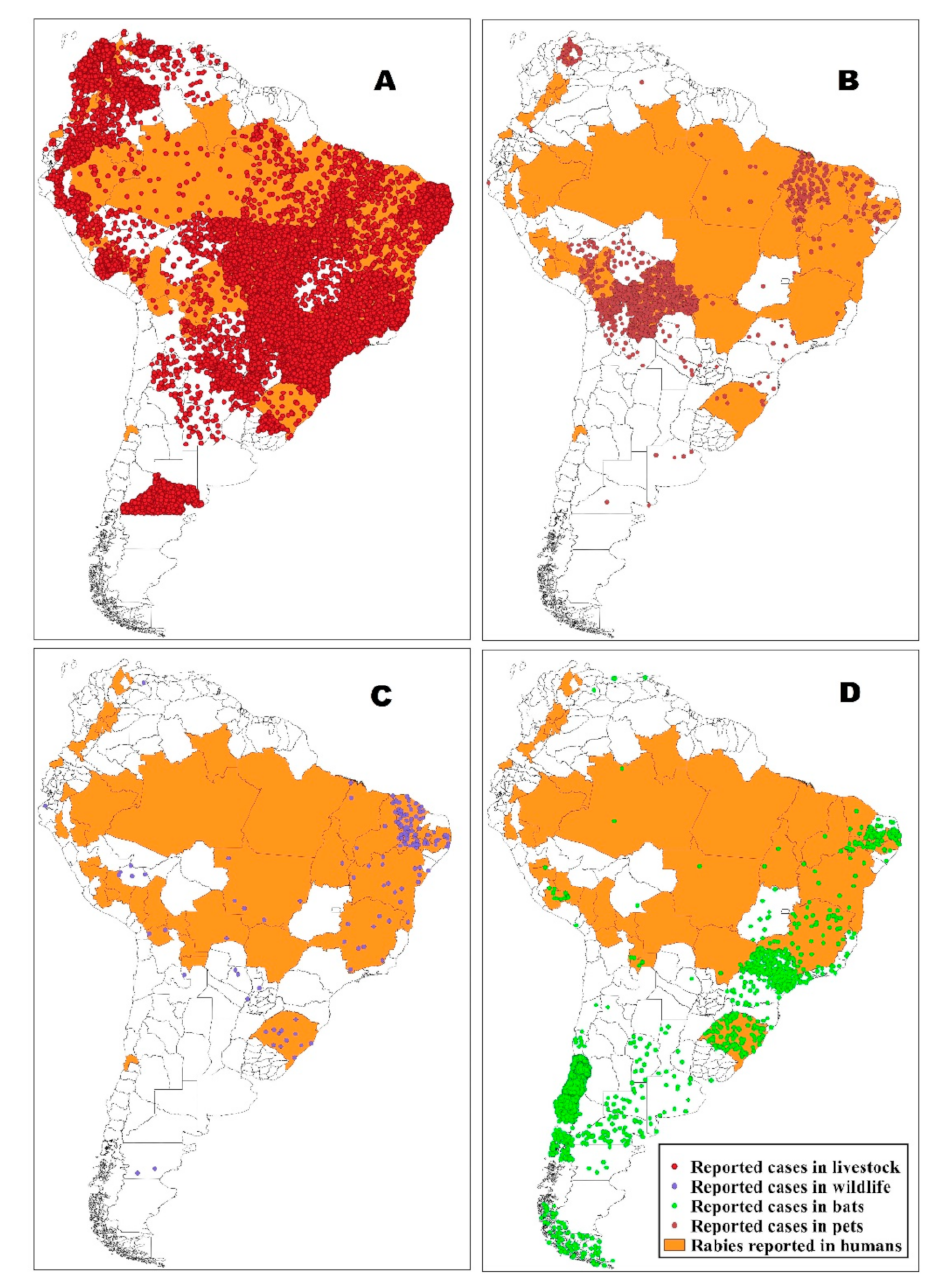
Figure 3. Distribution of the reported rabies cases, represented by dots, for 10 years (2009 to 2018) in livestock ( A ), pets ( B ), wildlife other than bats ( C ), bats ( D ), and comparison with rabies cases reported in humans represented by orange areas. The distribution of the cases is represented using the “density dot”